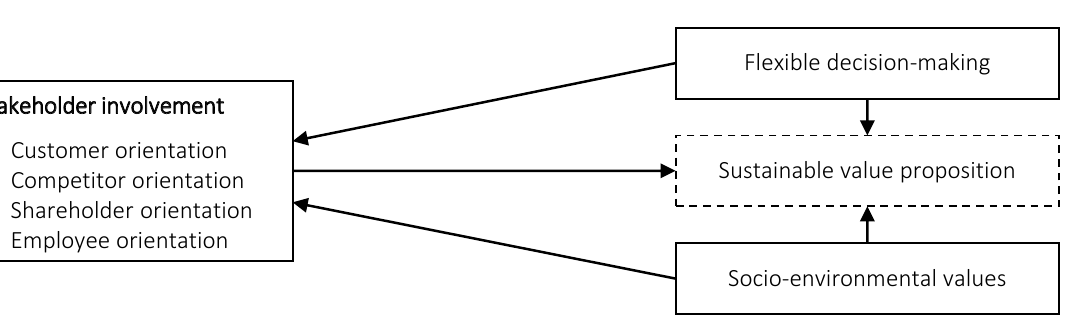
Figure 1. Conceptual